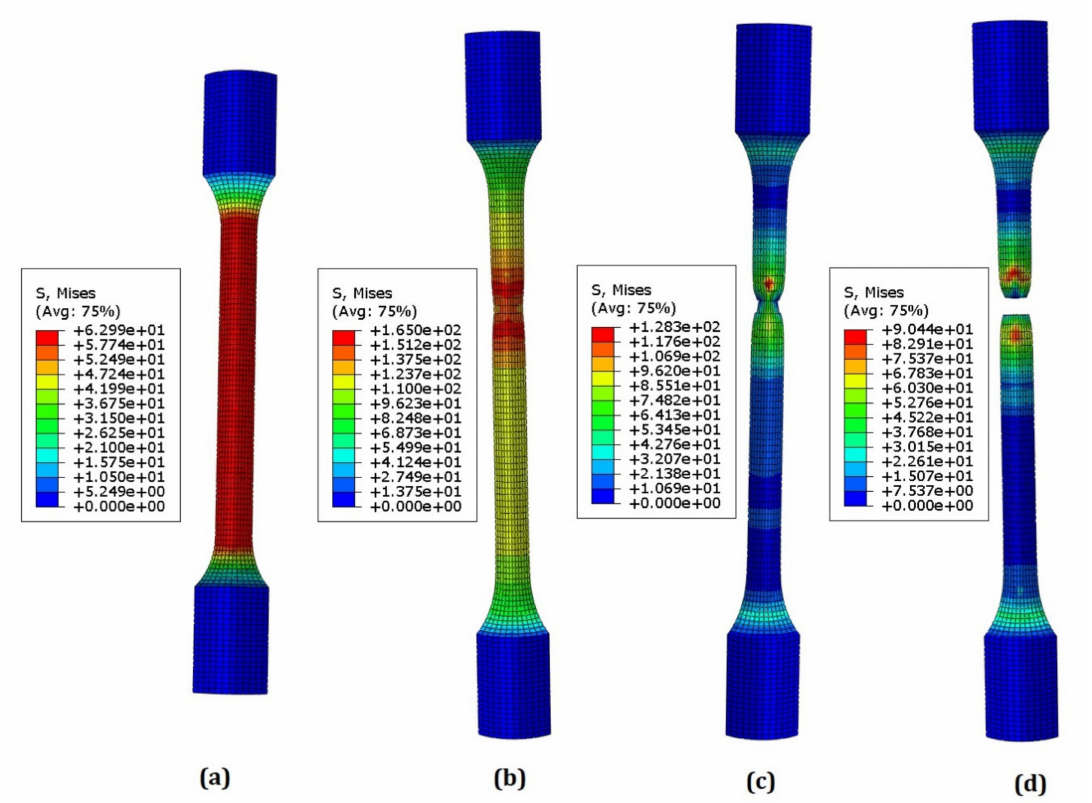
Figure 6. Von Mises stress distribution at ( a ) loading ( b ), ( c ) necking ( d ) rupture for ST